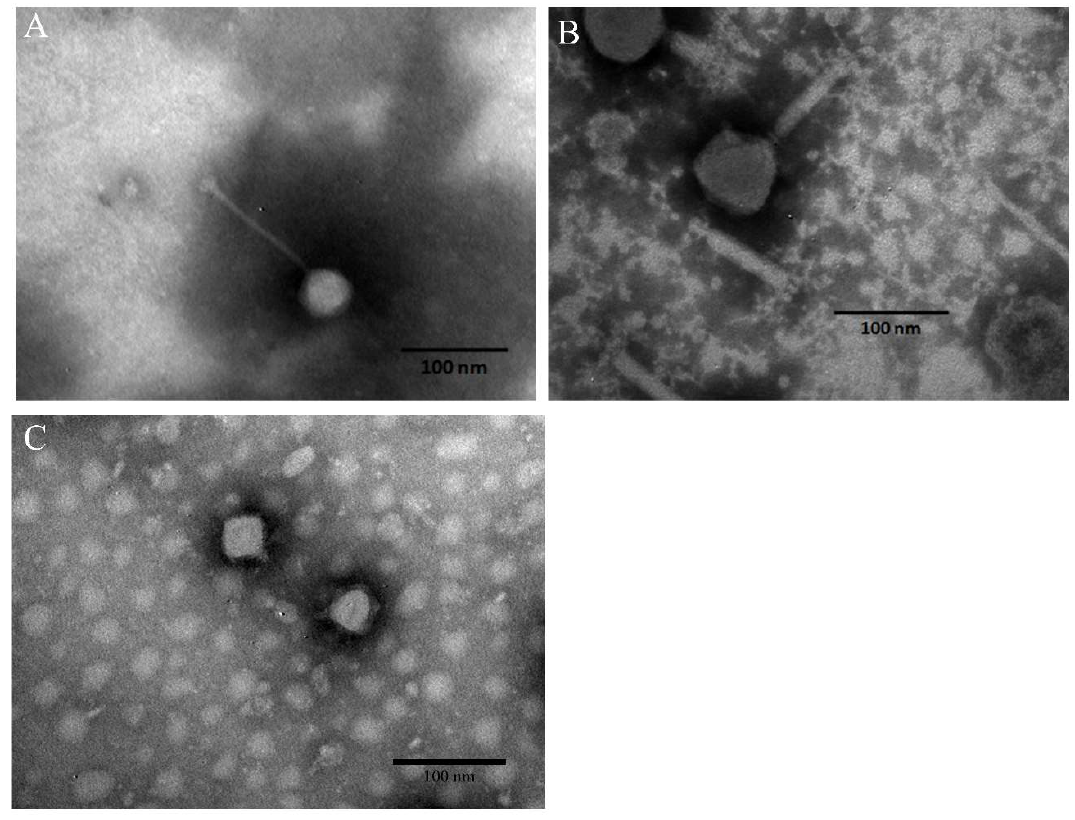
Figure 2. Morphological characteristics of phages. ( A ) TEM image of phage LPSTLL; ( B ) TEM image of phage LPST94 and ( C ) TEM image of phage LPST153. Bar 100 nm.